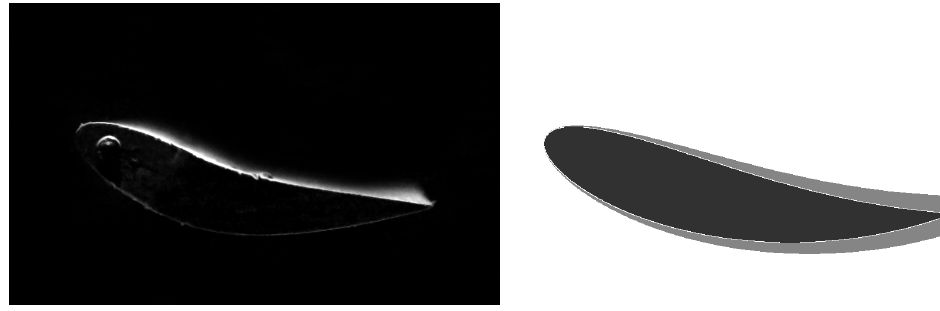
Figure 5. ( Left ) High-speed recording of the hydrofoil motion. The hyper-flexible hydrofoil encoun- ters strong deformations for high angles of incidence. ( Right ) PIV mask generated from PIV raw data with thickened tail (grey) to cover three-dimensional deformation effects and recognized NACA0018 structure (black). The recordings belong to two different measurement